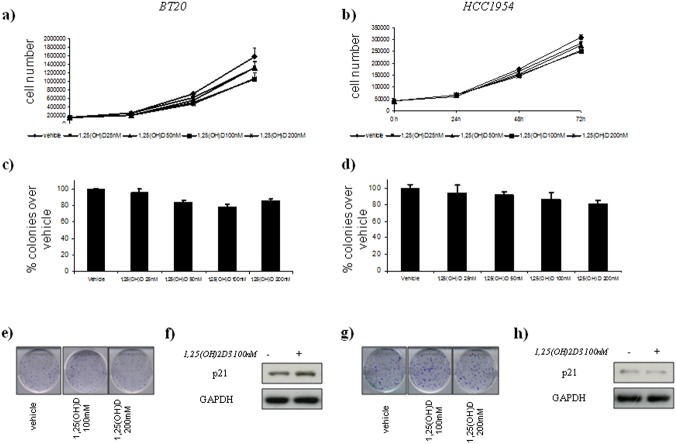
Vitamin D anticancer effects in vitro on ER(–) breast cell lines with GG Cdx2 status.Time-dependent growth curves of BT20 (a) and HCC1954 (b) cells in the absence or in the presence of different doses of 1,25(OH)2D3 (25–200 nM). Histograms (c and d) showing average colony percentage over vehicle from duplicate experiments at 10–21 days from seeding. Bars indicate the average of three independent experiments. Representative micrographs of colonies formed by BT-20 (e) and HCC1954 (g) cells treated with 1,25(OH)2D3 as indicated. Representative western blot analysis of whole cell lysates obtained from BT20 (e) and HCC1954 (f) cells treated as suggested and stained with the indicated antibodies. GAPDH staining was used as a loading control.